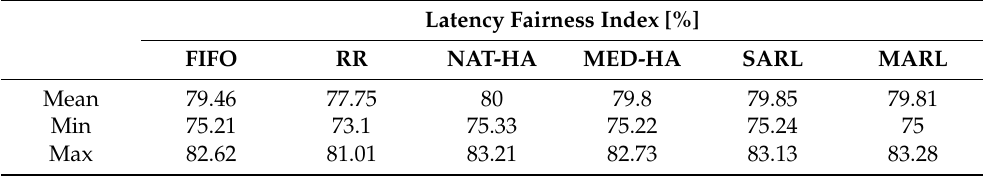
Figure 20. Box plot of latency fairness index per scheduler from 10,000 episodes in topology 2 with the random flow. Table 12. Latency fairness in topology 2 with random